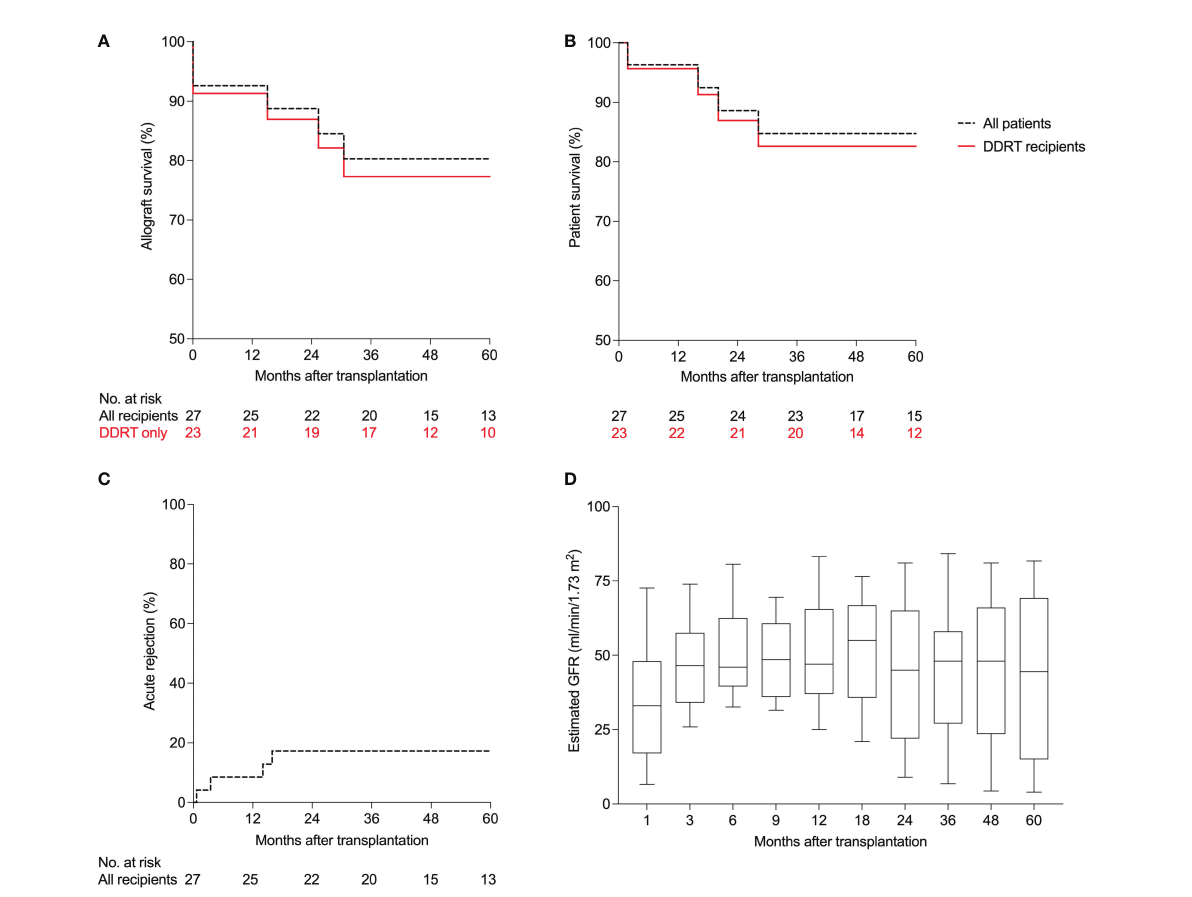
FIGURE 2 Patient and allograft outcomes of HIV-infected kidney transplant recipients managed with anti-thymocyte globulin induction (n=27). (A) Kaplan- Meier estimates of allograft survival, (B) patient survival, (C) and acute rejection. (D) Estimated glomerular fi ltration rates (GFR) using the 4- parameter Modi fi cation of Diet in Renal Disease (MDRD) formula. Boxplots show the 10 th , 25 th , 50 th , 75 th , and 90 th percentiles. DDRT, deceased donor renal